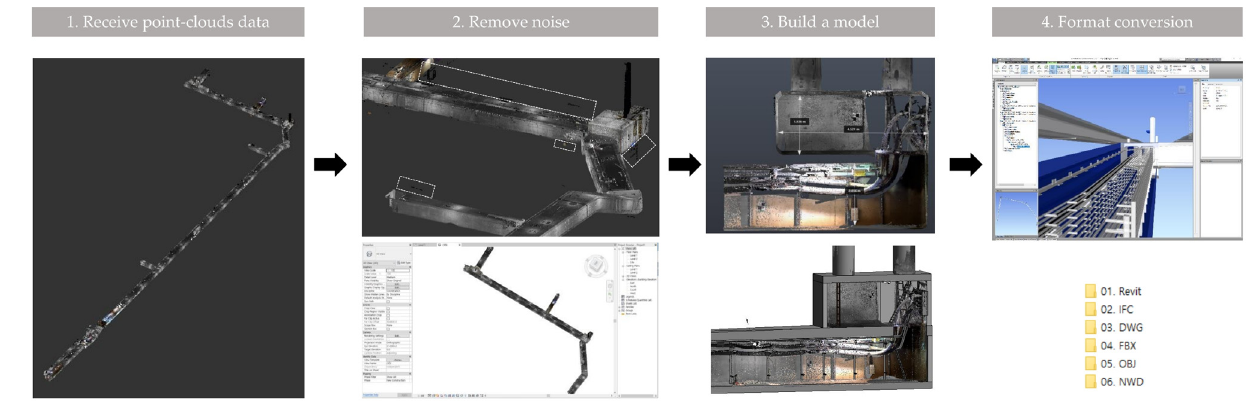
Figure 4. BIM model building procedure based on a laser scan.